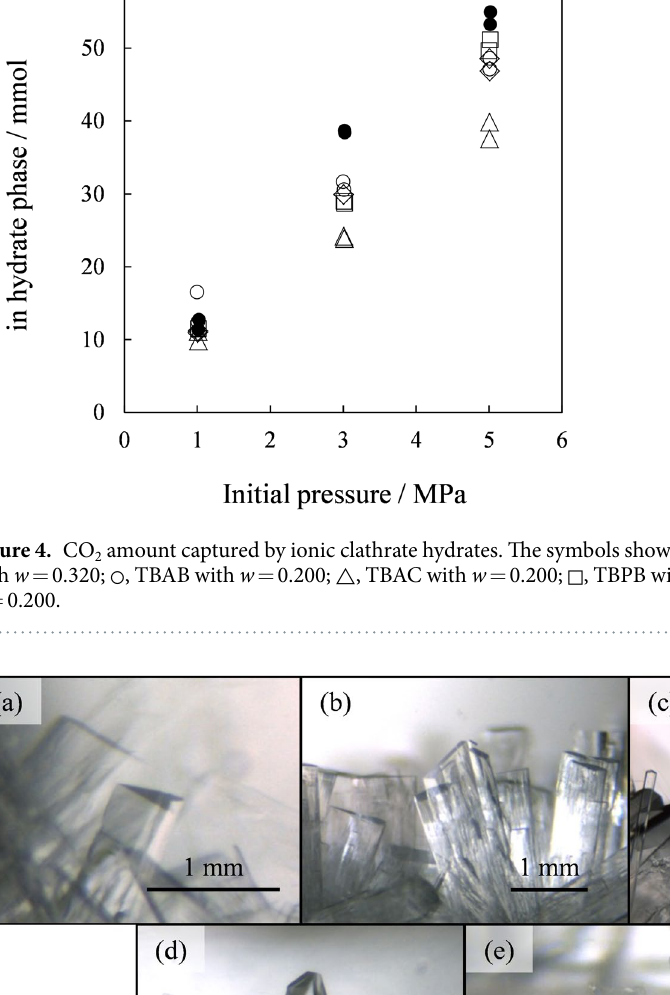
5 Scientific RepORtS | 7: 17216 | DOI:10.1038/s41598-017-17375-1